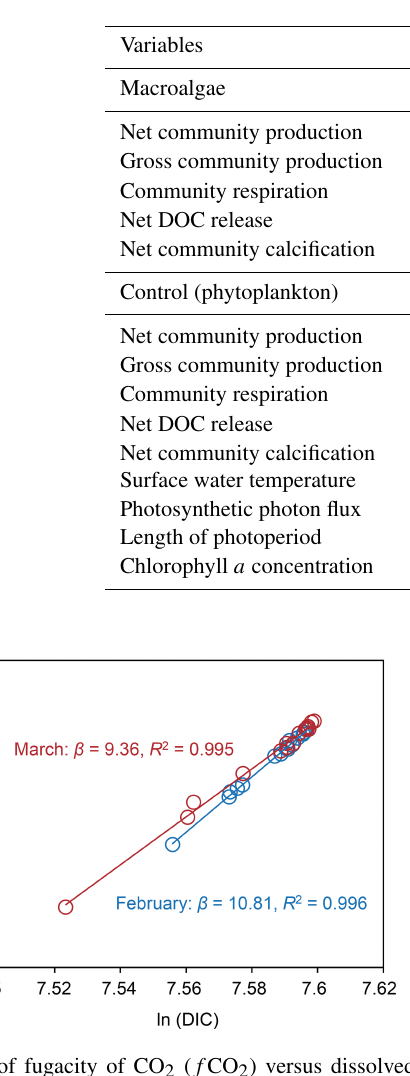
Table 1. Carbon metabolism, surface water temperature, photosynthetic photon flux, length of photoperiod, and chlorophyll fluorescence in February and March 2019. For macroalgae, means ± standard deviations are shown. Average water depth and biomass in the bed were used for calculating metabolic rates.